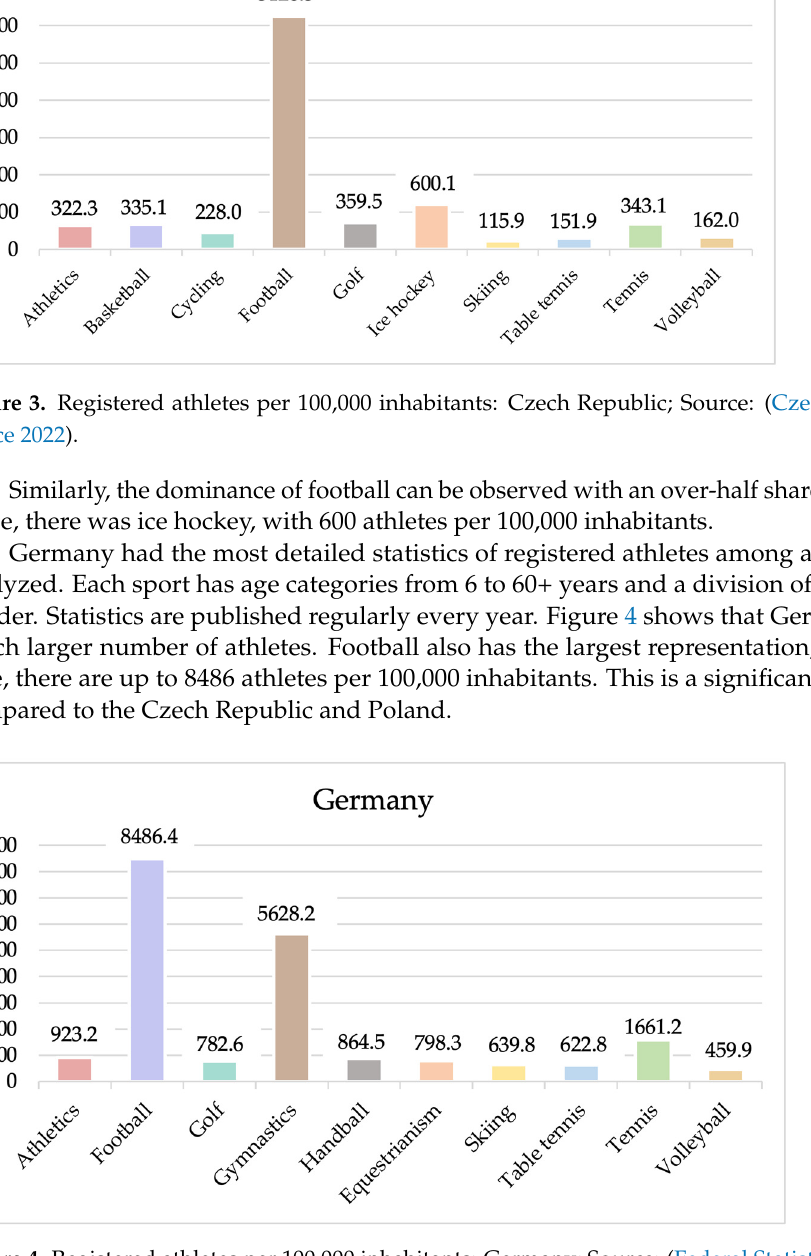
Figure 4. Registered athletes per 100,000 inhabitants: Germany; Source: (Federal Statistical Office of Germany 2022).